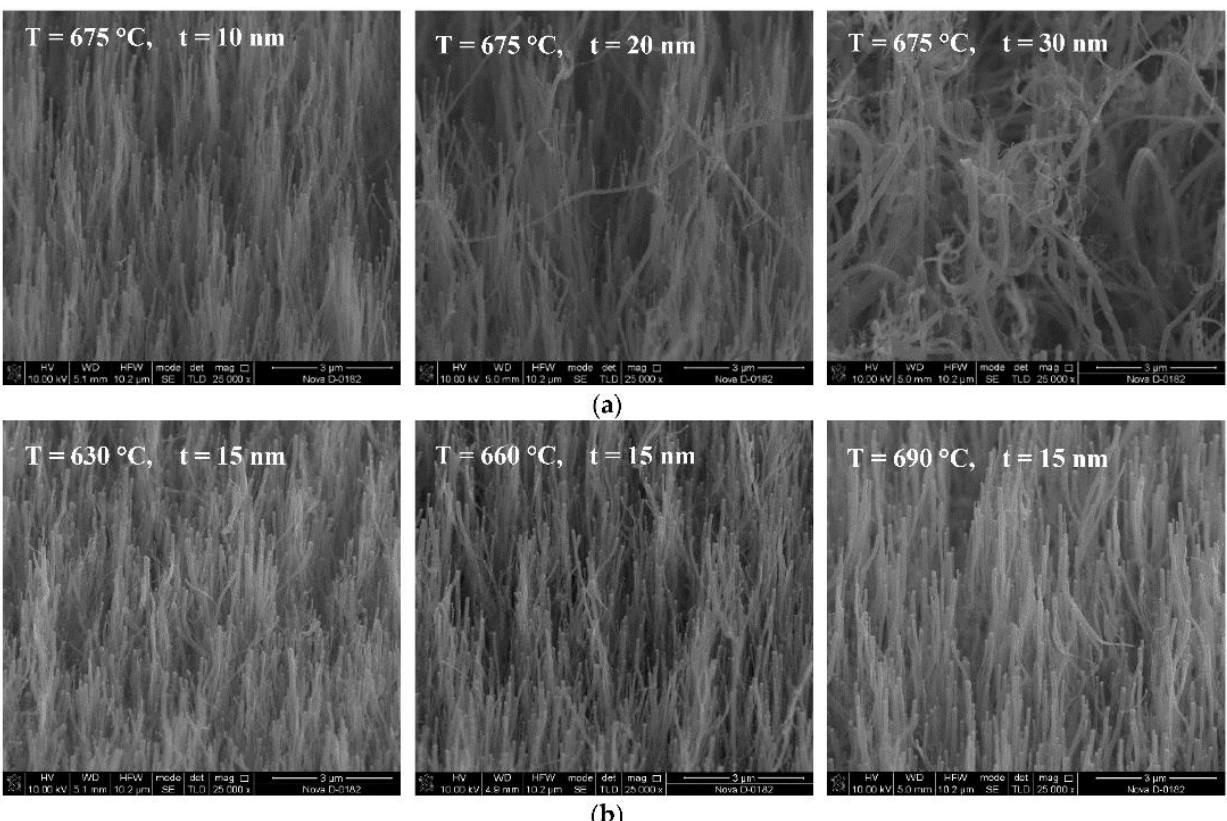
Figure 11. ( a ) The SEM images of CNT arrays grown at 675 ◦ C and different catalyst layer thicknesses t = 10–30 nm, and ( b ) at catalyst layer thickness t = 15 nm, and at different temperatures 630–690 ◦ C. Reprinted from Ref. [14]. Copyright 2021 by the authors. Licensee MDPI, Basel, Switzerland.